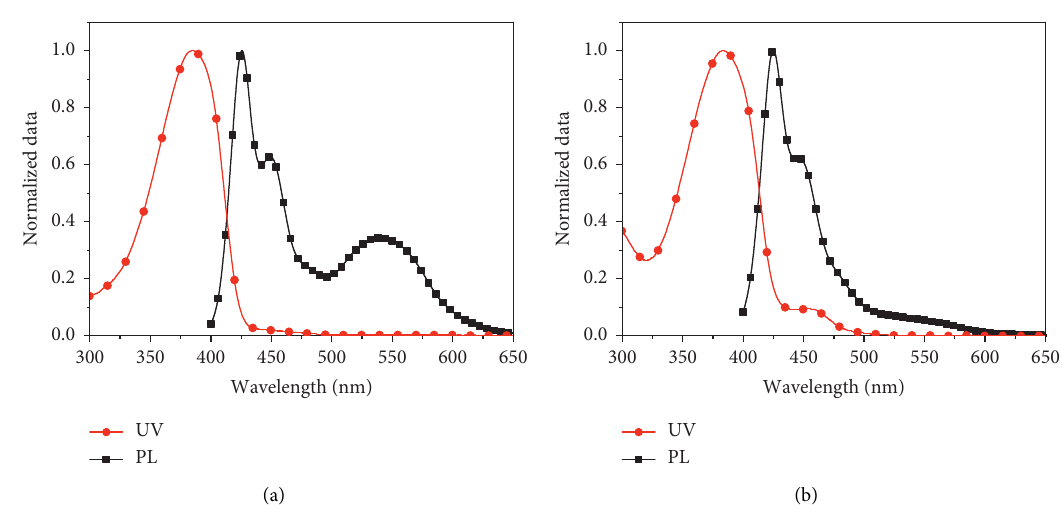
Figure 5: The UV-vis absorption and PL spectra P4 (a) and P4 ′ (b) in water (excitation at 384nm).